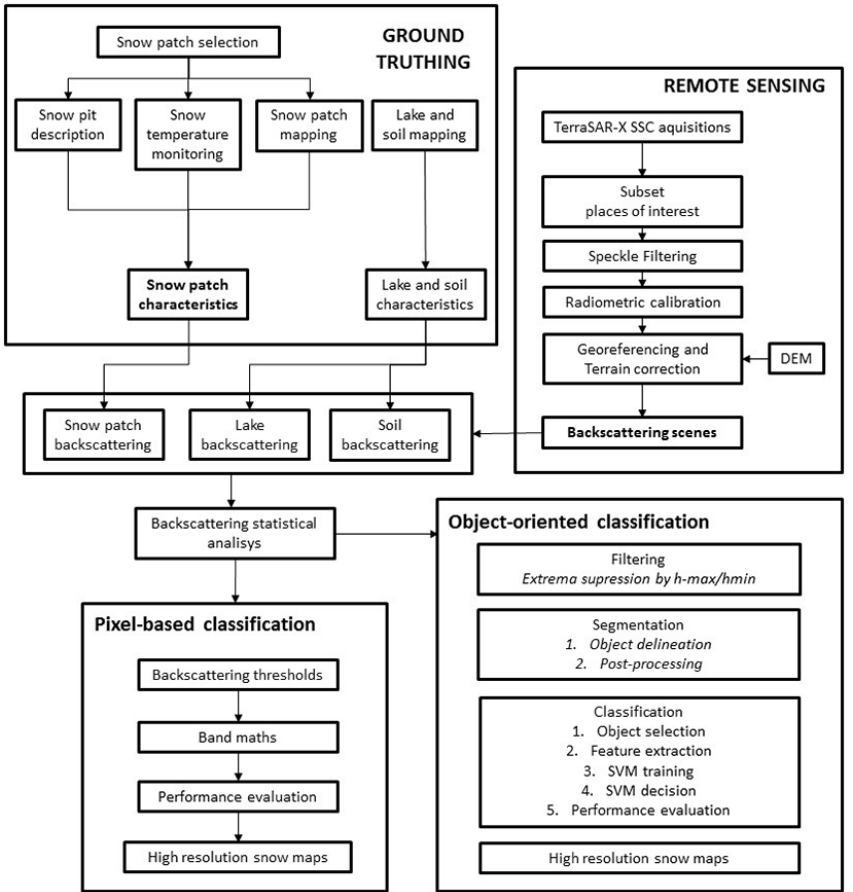
Figure 3. Methodology for the evaluation of the potential of Spotlight mode TerraSAR-X imagery for high-resolution snow cover